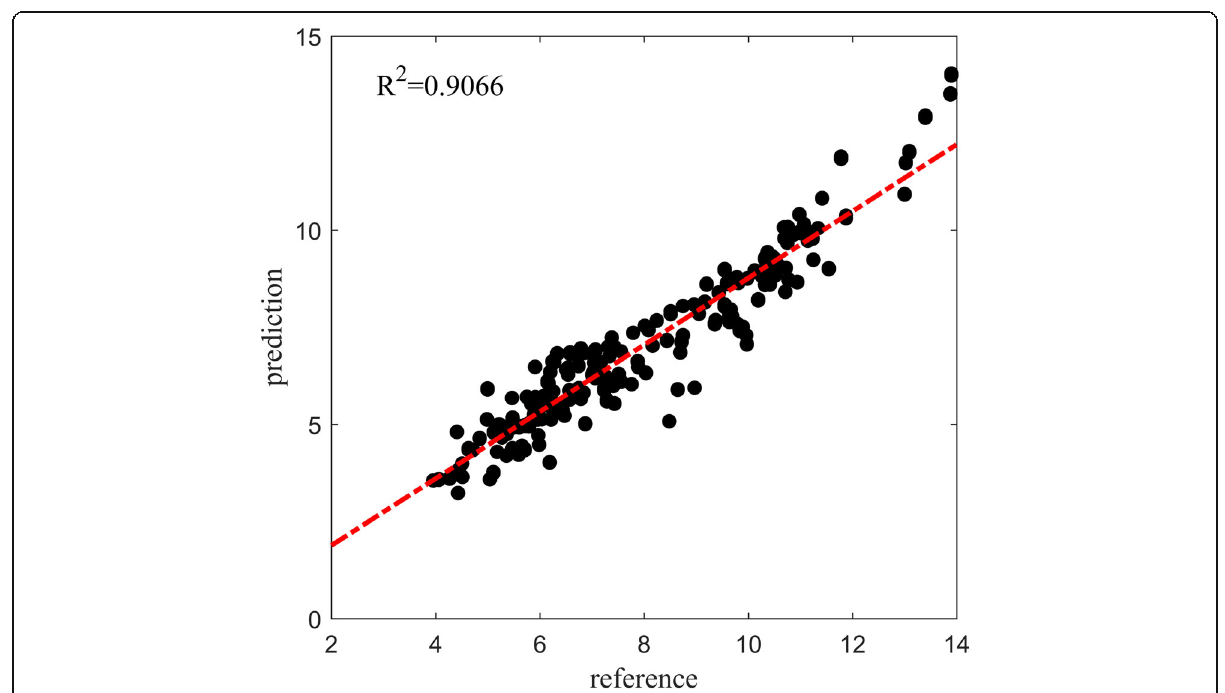
Fig. 6 Scatter Plot of ln (reference) and